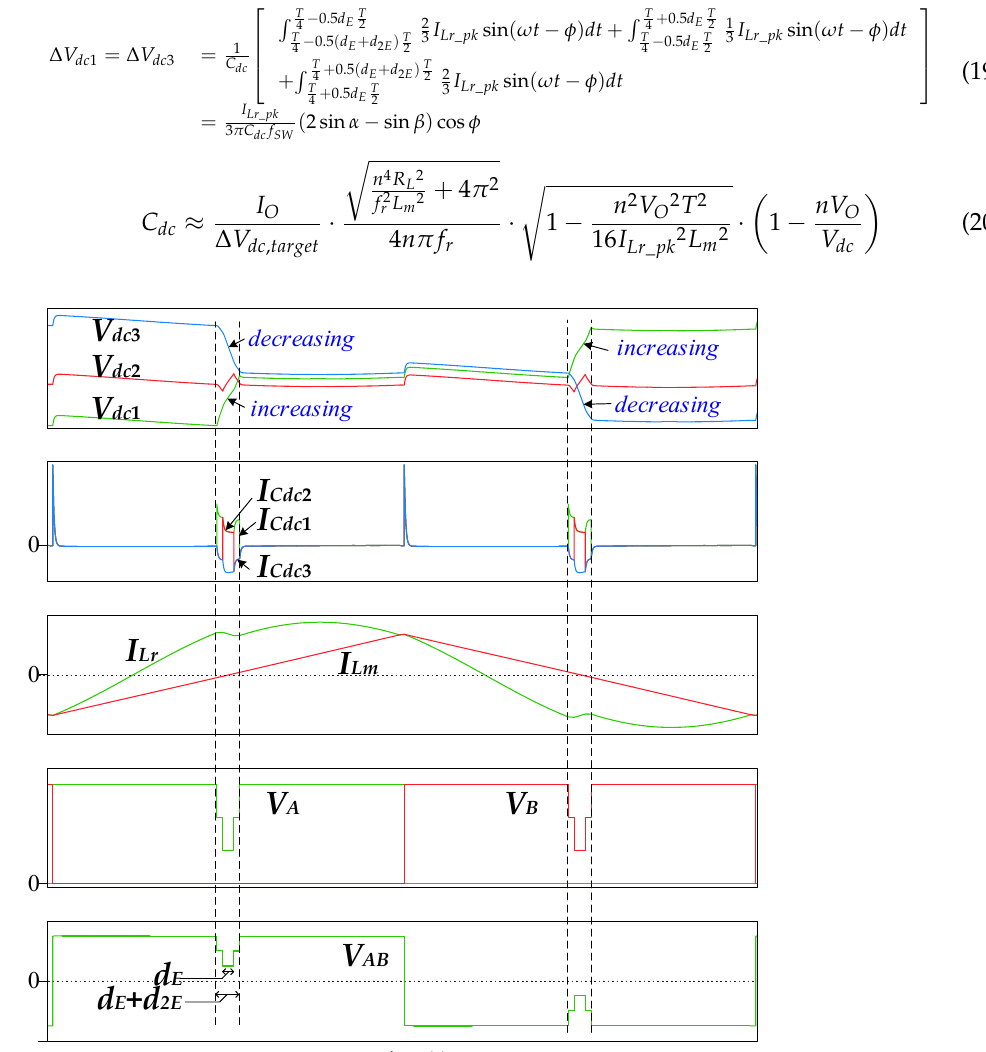
between the UCM and LCM at every resonant period in a steady state, the total voltage change per unit capacitor becomes 2 × ∆ V dc .